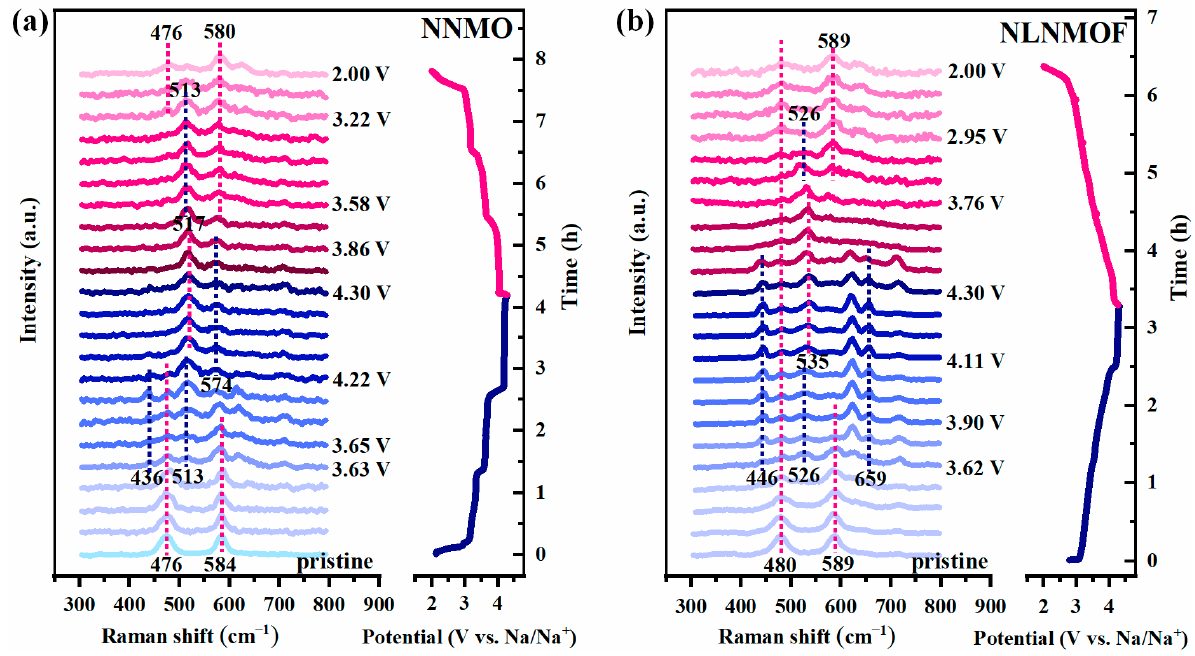
Figure 5. In situ Raman spectra of ( a ) NNMO and ( b ) NLNMOF electrodes acquired during the first cycle.